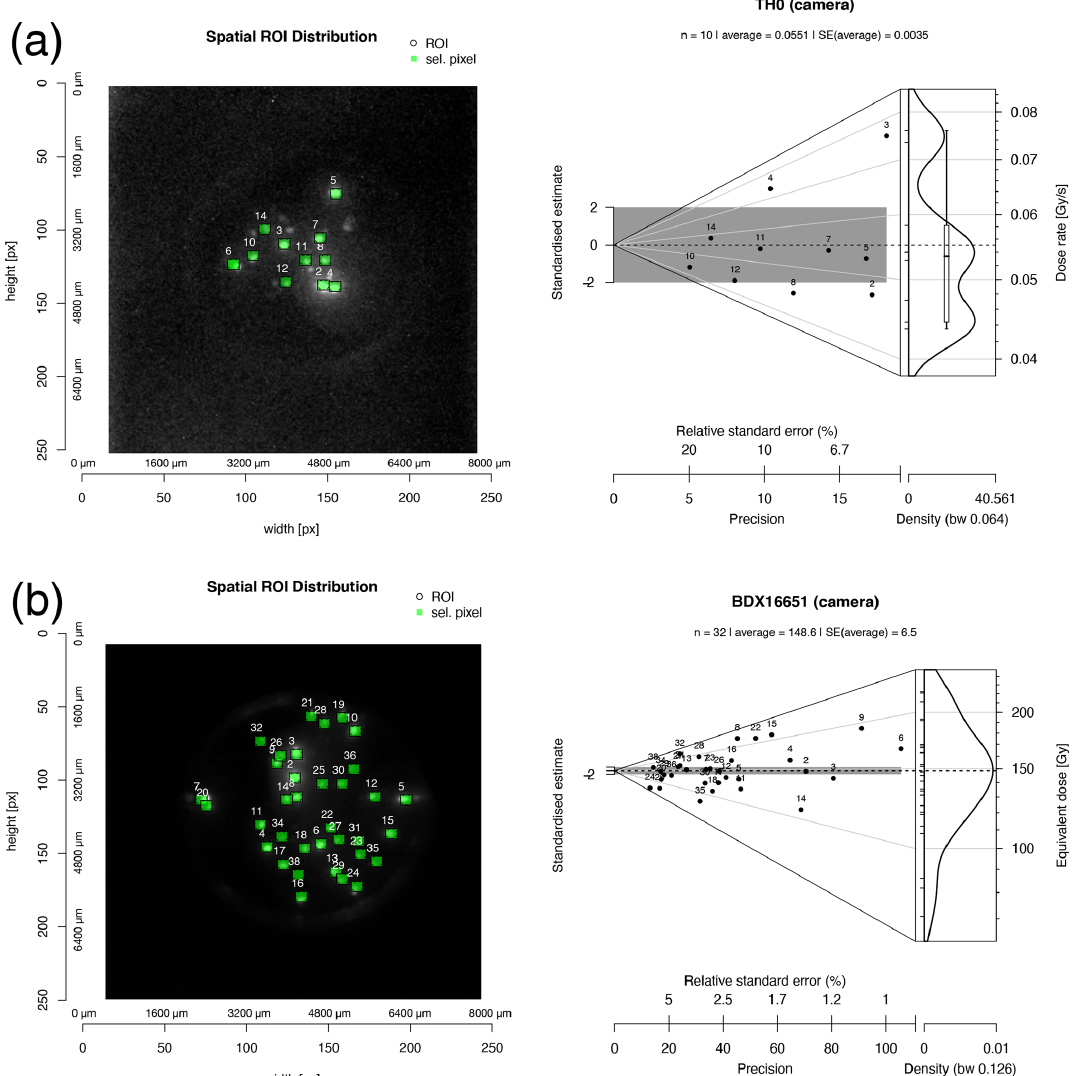
Figure 6. The figure shows the SR IR-RF measurement results for single grains from samples TH0 (a) and BDX16651 (b) . For each sample, the image of one aliquot with the selected ROIs (green) is plotted on the left-hand side, and the resulting D e distribution as Abanico plot (Dietze et al., 2016) on the righthand side. Numbers (white) in the plots identify individual ROIs. The distribution for TH0 shows dose rates and the distribution for BDX16651 equivalent doses. Note: the original images returned by the SR-RF macro have been cropped and reworked in R for this